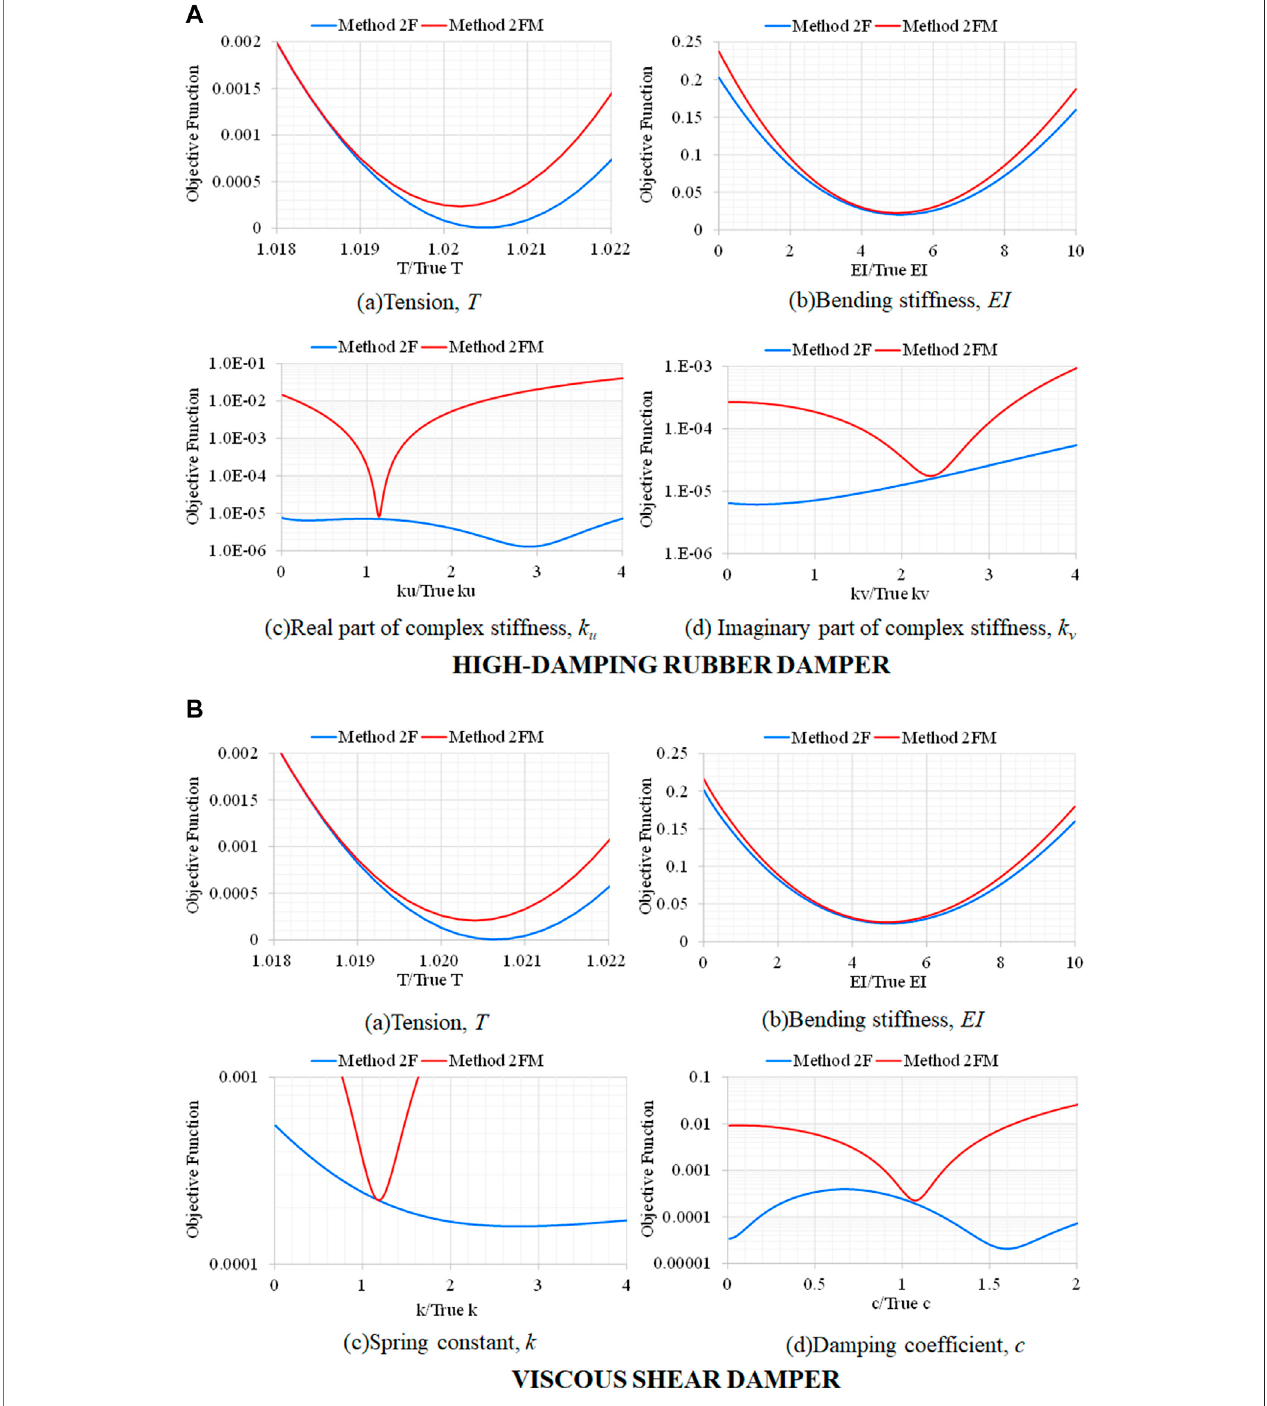
FIGURE 7 | Sensitivity analysis results for model No. 33 with measurement error of 1%: (A) high-damping rubber damper; (B) viscous shear damper.